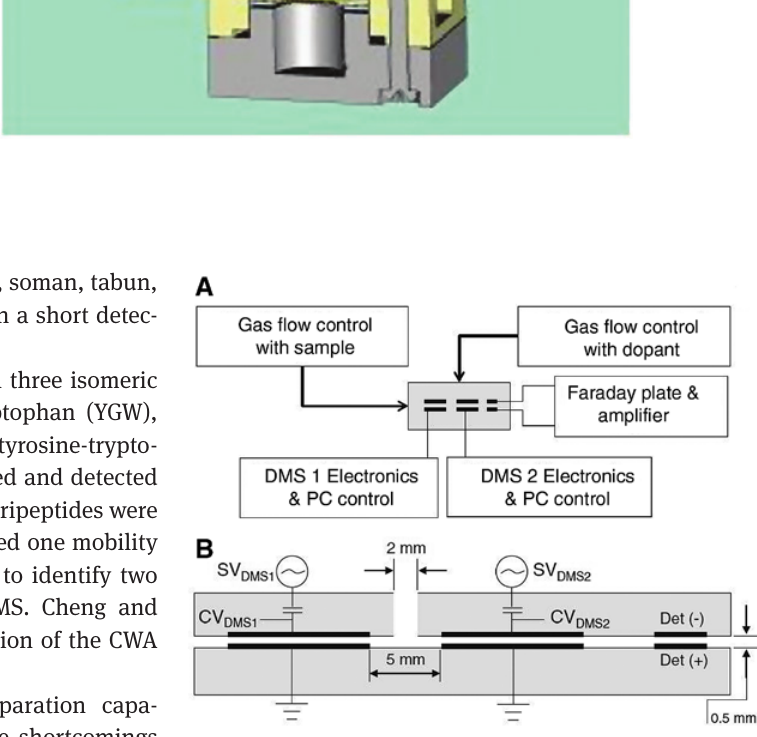
Figure 8: Schematic of a DMS/DMS system with enlarged graphics of the DMS/DMS